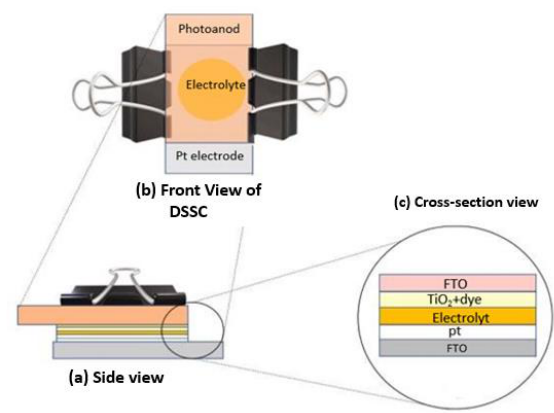
Figure 5. The assembly procedure of the FTO/TiO 2 -dye/electrolyte/Pt DSSCs from several view- points: ( a ) side view; ( b ) front view; ( c ) cross-section view.